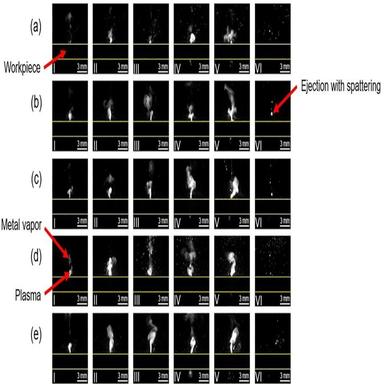
High-speed camera images showing the transient evolution of the through-hole drilling stage using the second laser pulse under different ultrasonic powers of (a) 0 W, (b) 156 W, (c) 311 W, (d) 467 W and (e) 622 W.